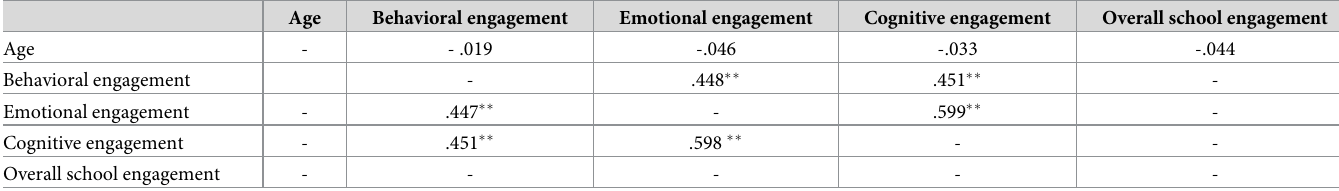
Table 4. Correlations among components and age (n = 537).